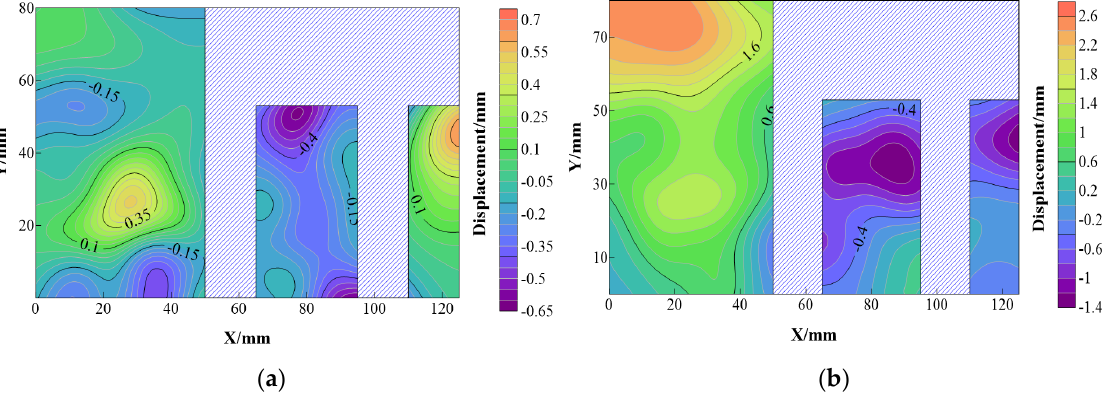
Figure 7. ( a ) X − direction contour diagram and ( b ) Y − direction contour diagram of soil displacement for MN − 8 model.